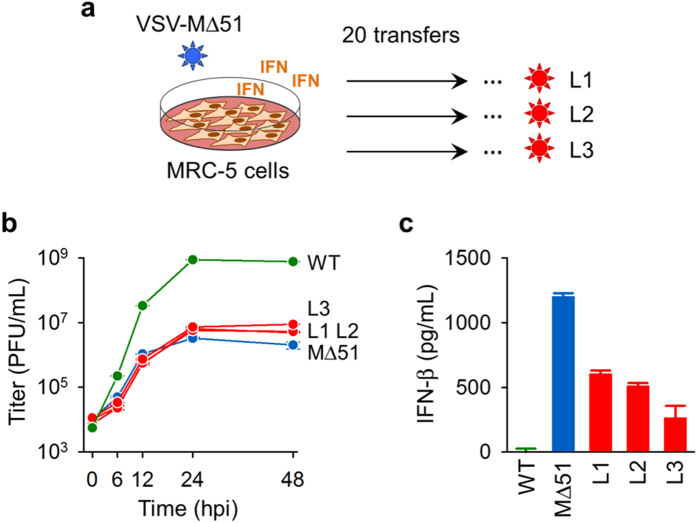
Adaptation of VSV-MΔ51 to IFN-competent MRC-5 cells.(a) Scheme of the serial transfers. VSV-MΔ51 was transferred 20 times at an MOI of 0.1 pfu/cell in triplicate (L1–L3). Cells were replaced after each transfer, such that only the virus was allowed to evolve. (b) Growth curves of the MΔ51 founder (blue), the evolved lines L1–L3 (red), and a reference virus (WT) showing no defects in the M protein (green). Error bars indicated the standard error of the mean (SEM) from three independent replicates (n = 3). (c) IFN-β production in a single infection cycle (MOI = 3 PFU/cell, 16 hpi) as determined by ELISA. Error bars indicate the SEM, with n = 3.